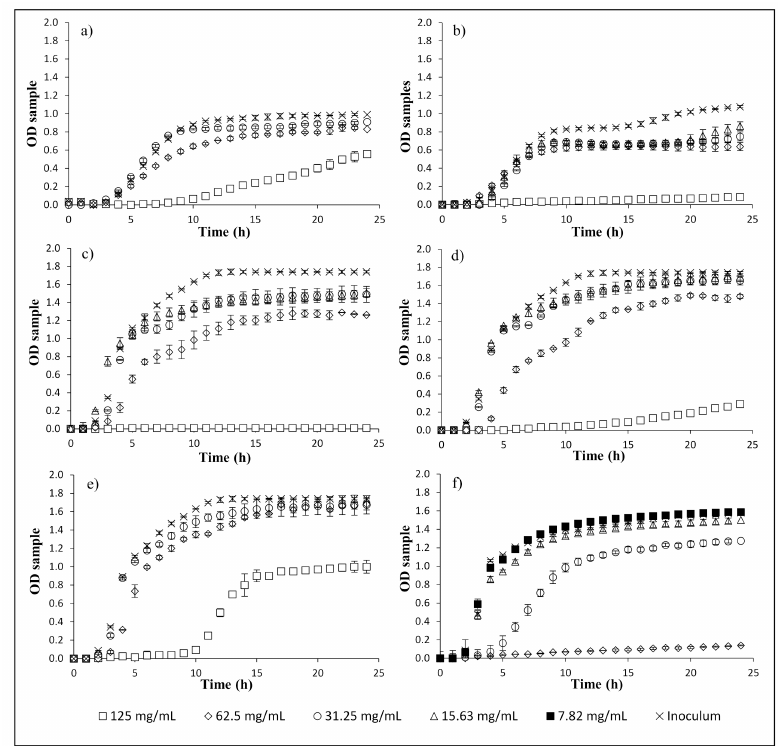
Figure 1. Inactivation curves for ( a ) S. aureus /OH; ( b ) S. aureus /HP; ( c ) S. enteritidis /OH; ( d ) S. enteri- tidis /HP; ( e ) S. enteritidis /OH and HP; ( f ) B. cereus